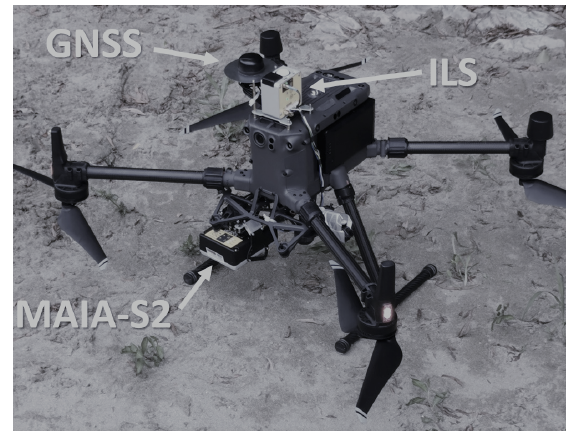
Figure 1. MAIA-S2 multispectral camera and Irradiance Light Sensor mounted on DJI Matrice 300 UAS.